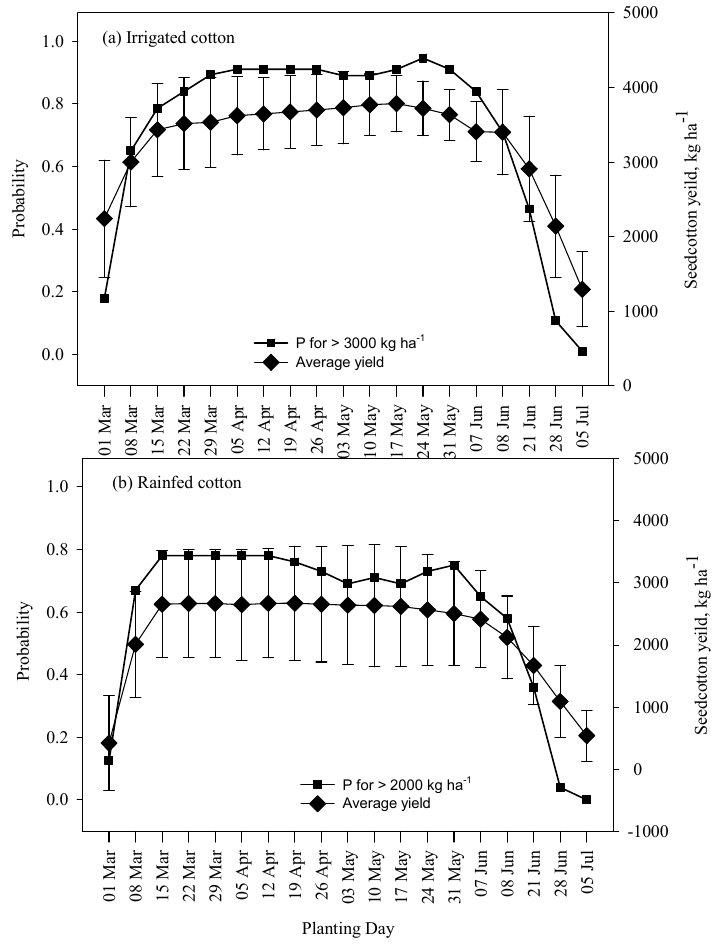
Figure 7. Mean simulated irrigated ( a ) and rainfed ( b ) seed cotton yields and the probabilities of achieving breakeven seed cotton yields (2000 kg ∙ ha − 1 for rainfed and 3000 kg ∙ ha − 1 for irrigated conditions) at Stoneville, MS. The crops were planted at weekly intervals from 1 March through 5 July.